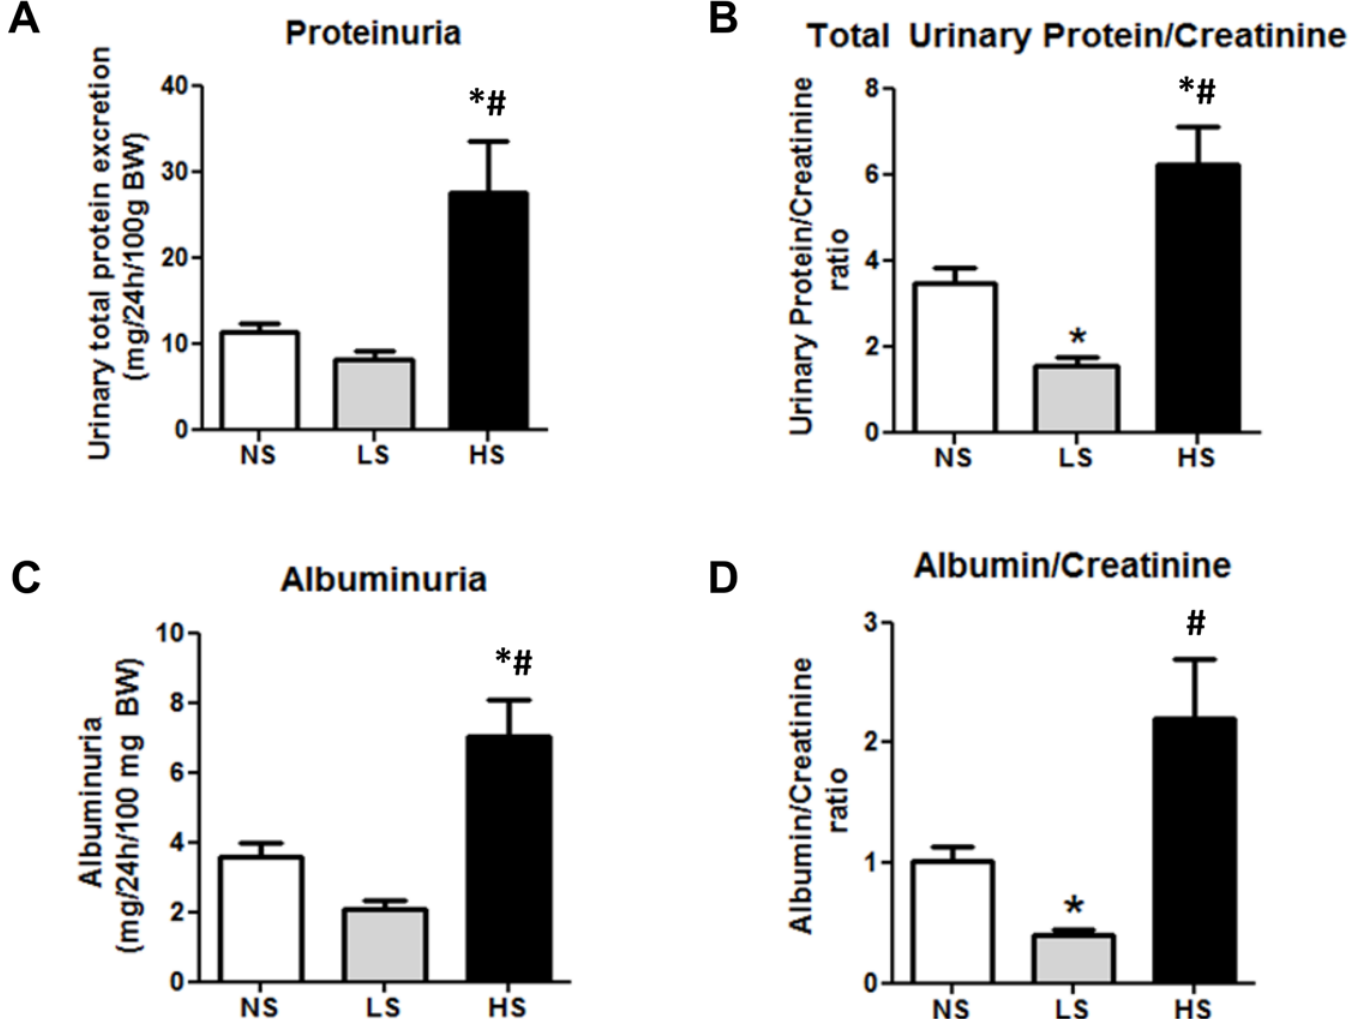
Fig 1. Analysis of the renal function in SHR. (A, B) proteinuria and urine protein/creatinine ratio. (C, D) Albuminuria and albumin/creatinine ratio. The analyses were performed with 24-h urine samples. Data are means ± SEM. NS: normal salt diet. LS: low salt diet. HS: high salt diet. * P < 0.05 vs. NS; # P < 0.05 vs LS. (NS n = 10, LS n = 14, HS n =